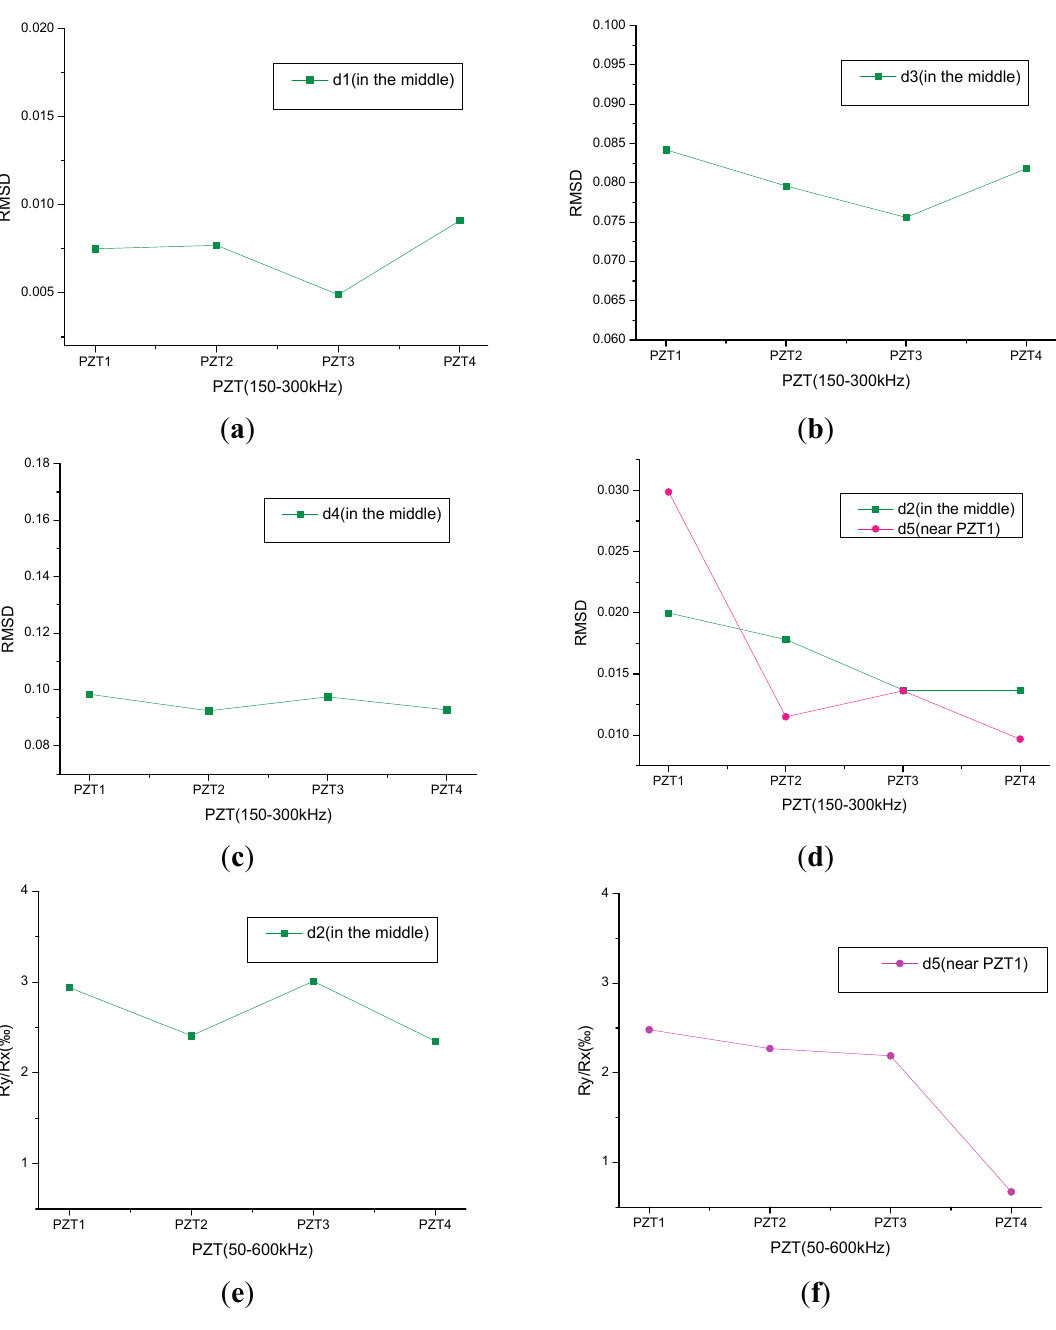
Figure 7. Distribution of damage indices of